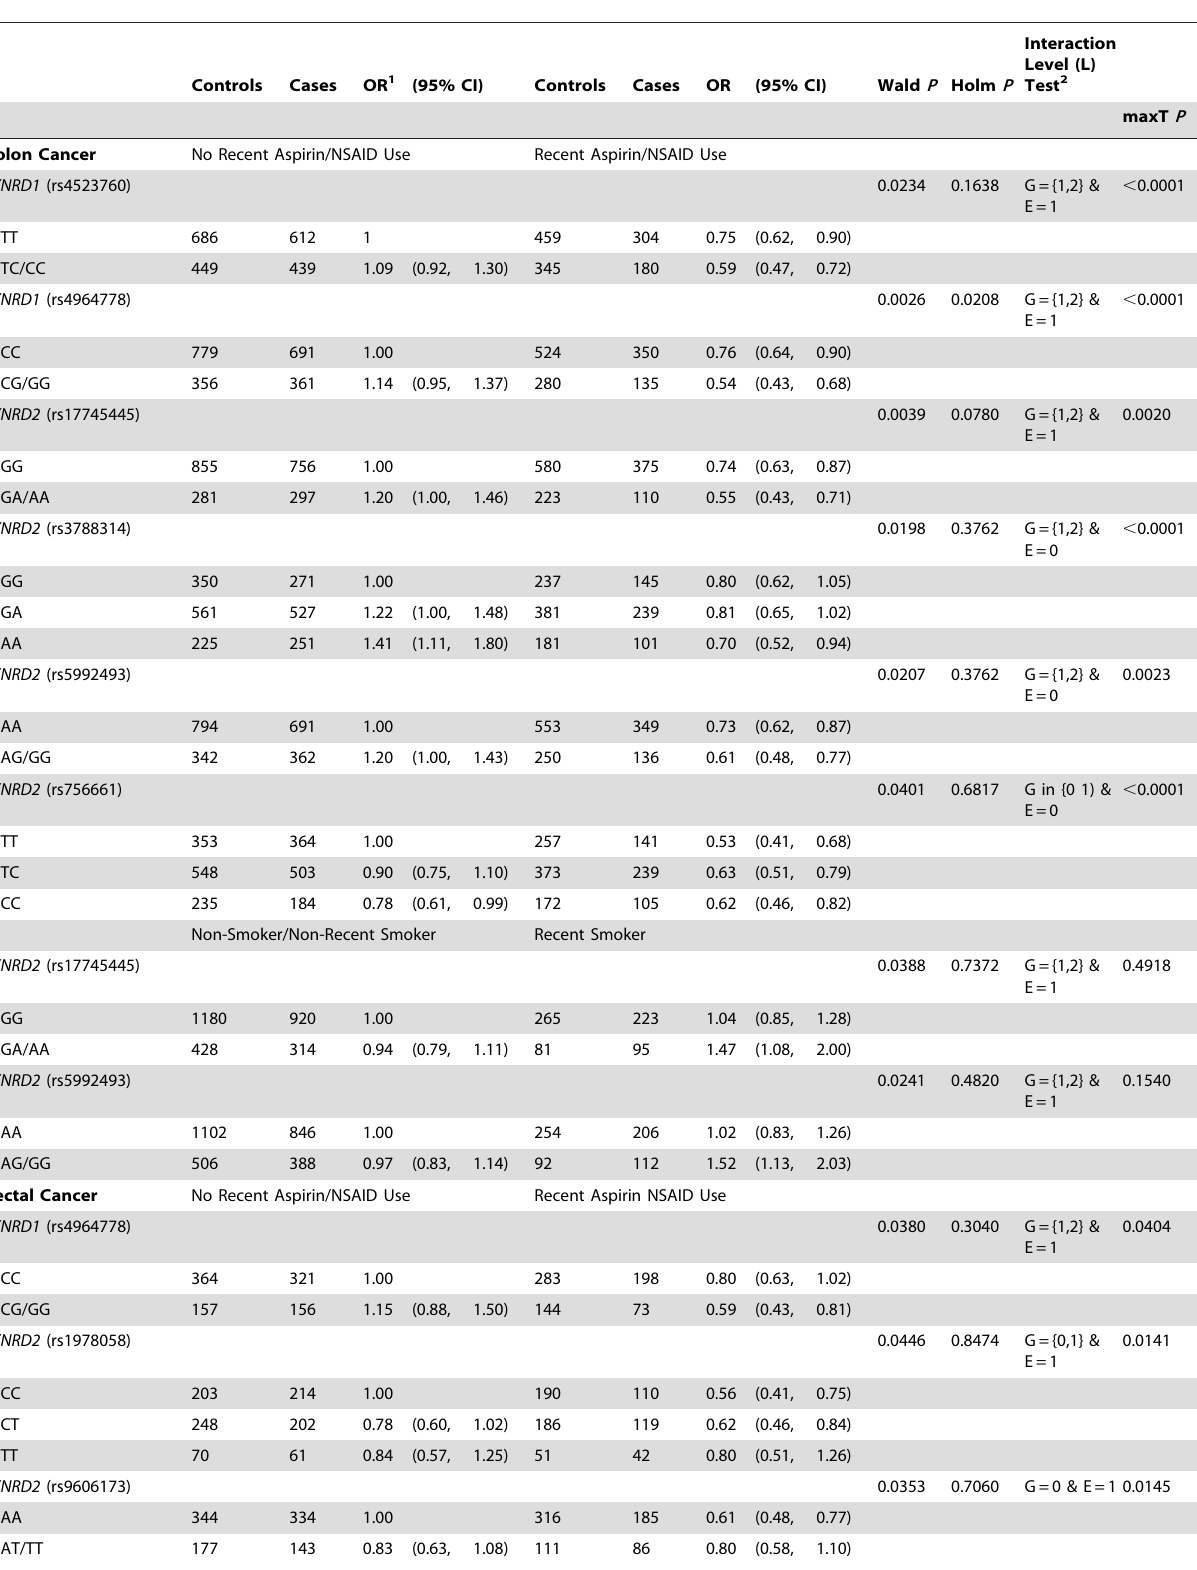
Table 3. Associations between TXNRD and selenoprotein SNPs, recent regular use of aspirin/NSAID, cigarette smoking and risk of colon and rectal